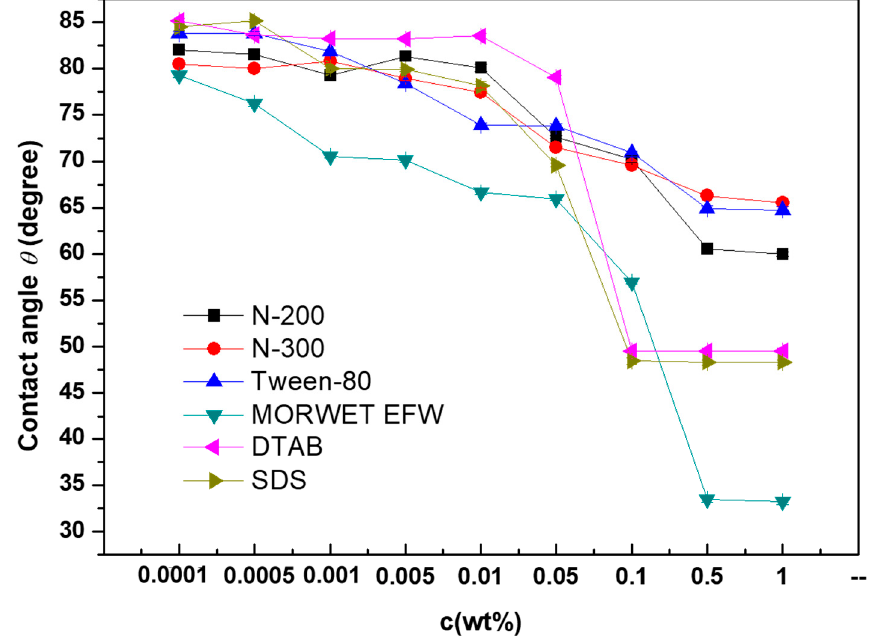
Figure 3. The relationship between the values of the contact angle ( θ ) on tea leaf surfaces and the surfactant concentration ( C , wt%).